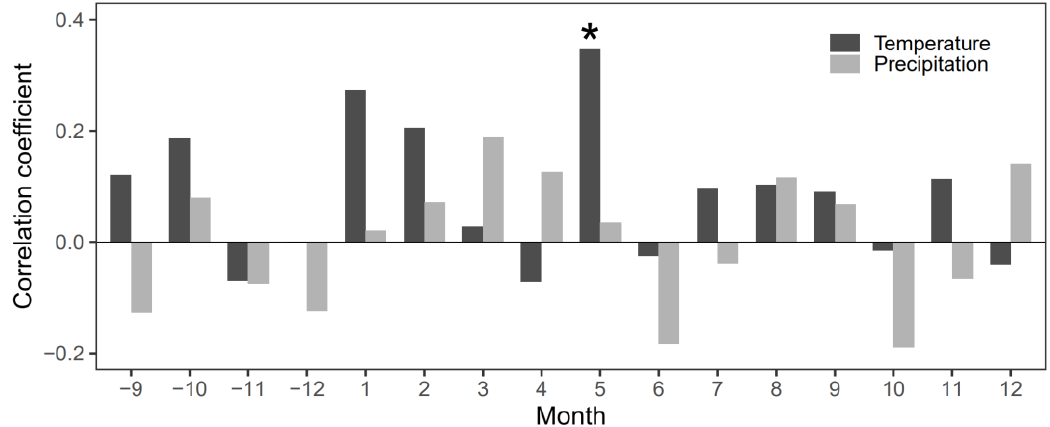
Figure 5. Bootstrapped correlation coefficients of the regional chronology were established by the mean of the chronologies at three sites with monthly mean air temperature and monthly precipitation, respectively, from September of the previous year ( −9 ) to December of the current year (12) from 1966 to 2018. Asterisk denotes that the correlation between the two variables is significant at the 95% confidence level ( p < 0.05).